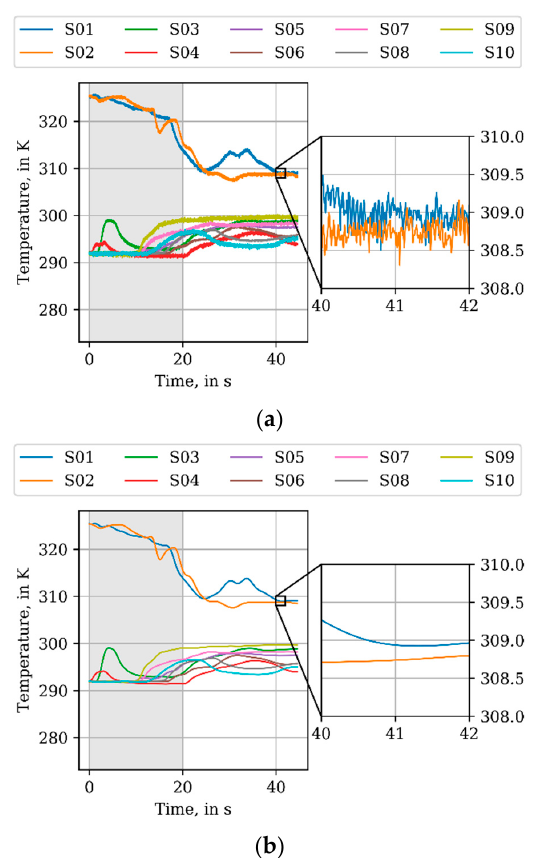
Figure 7. Temperature signal ( a ) before and ( b ) after the low-pass filter.